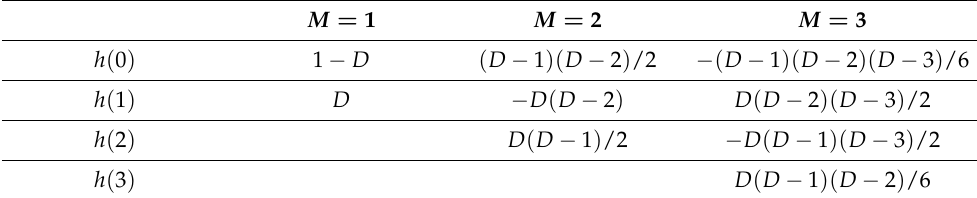
Table 3. Coefficients of the Lagrange FD